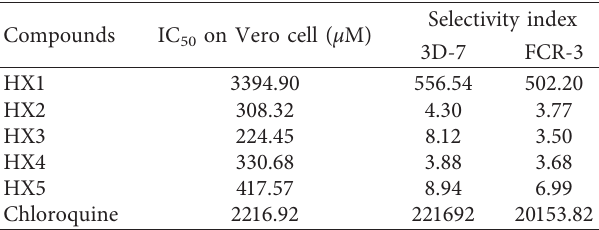
50 on Vero cell/IC 50 on